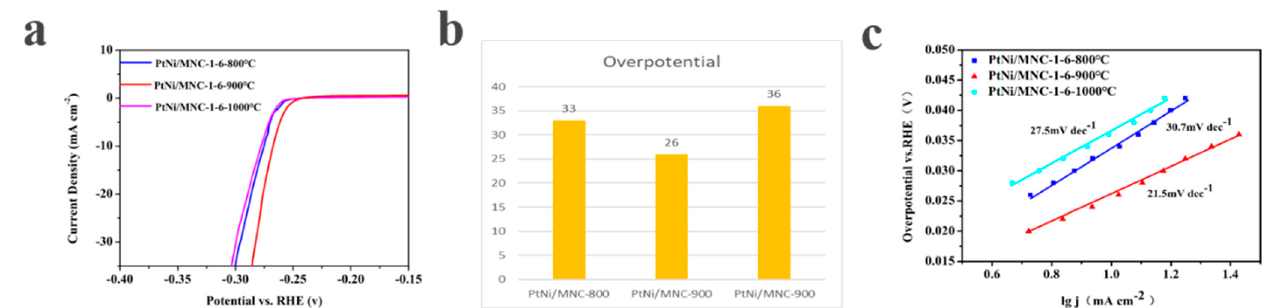
Figure 5. ( a ) HER polarization curve of the carrier-supported catalysts with different carbonization temperatures (polarization curves without i–R correction recorded in a 0.5 M H 2 SO 4 solution at a sweep rate of 5 mV s − 1 ); ( b ) the corresponding overpotential; ( c ) the fitted Tafel curve of the corre- sponding polarization curve.